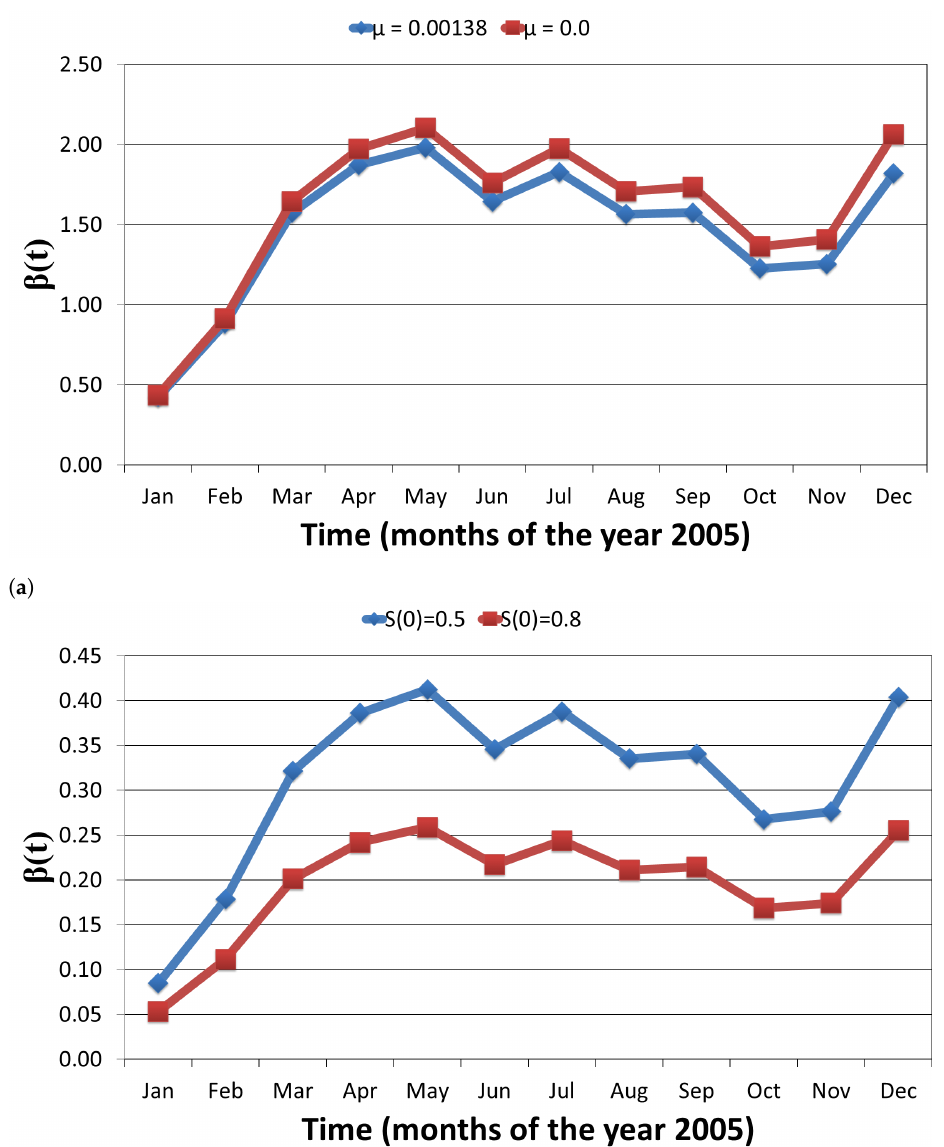
Figure 5. Estimates of β ( t ) for the 2005 outbreak of Visceral Leishmaniasis in the Indian state of Bihar, using available incidence data: ( a ) Estimates of β ( t ) related to an outbreak of Visceral Leishmaniasis, when the initial value of susceptibles, S ( 0 ) = 0.1; ( b ) Estimates of β ( t ) for two initial proportion of susceptibles in a population affected with Visceral Leishmaniasis. Estimates of β ( t ) obtained for two different values of the mortality rate, µ , (0.0 and 0.00138) are almost